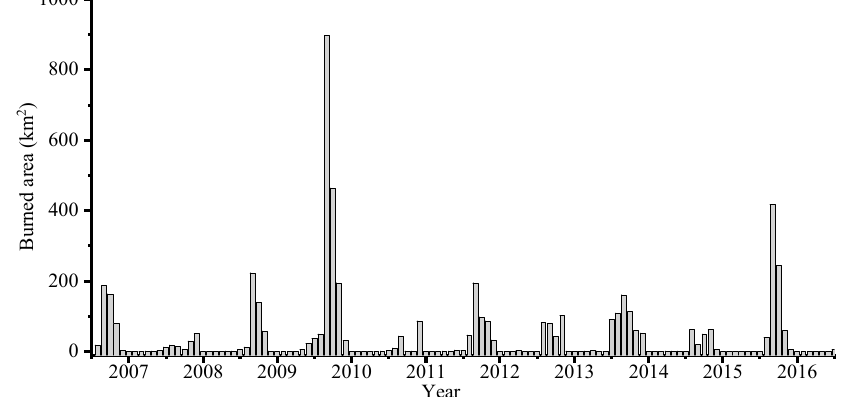
Figure 2. Burned area per month from 2007 to 2016 extracted from MCD64A1 product over southwest